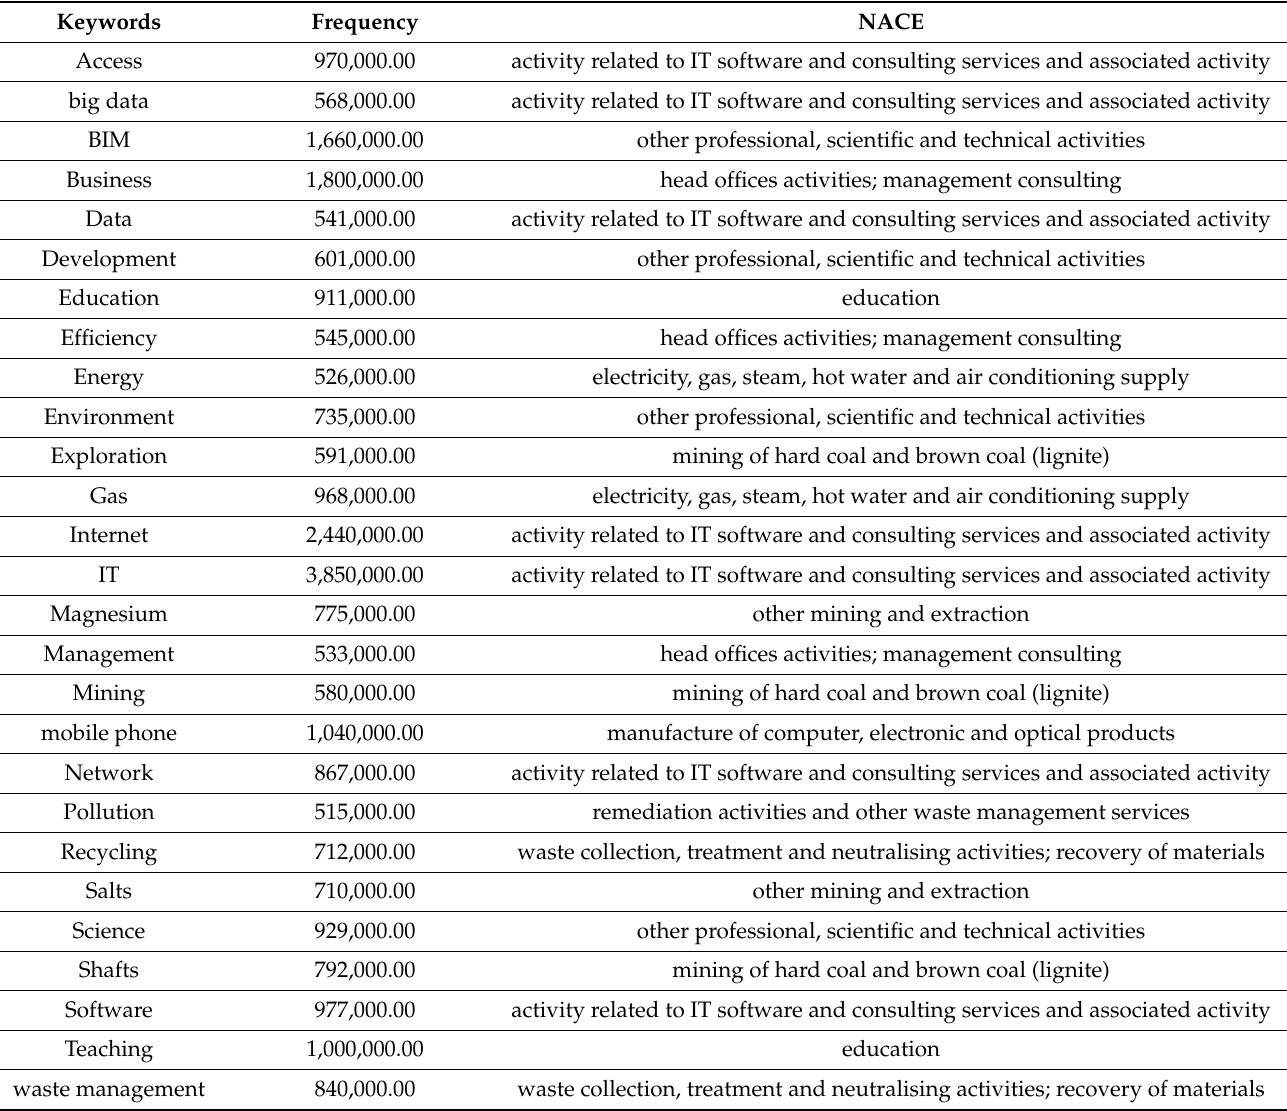
Table 1. Matching keywords with relevant categories from the NACE (own study).